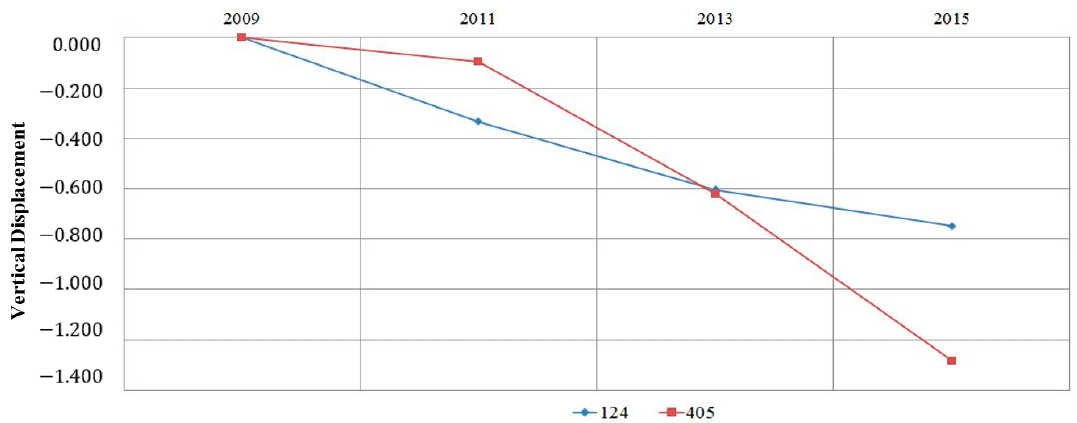
Figure 8. Vertical displacement evolution over time in points 124 and 405 from Mine 2.